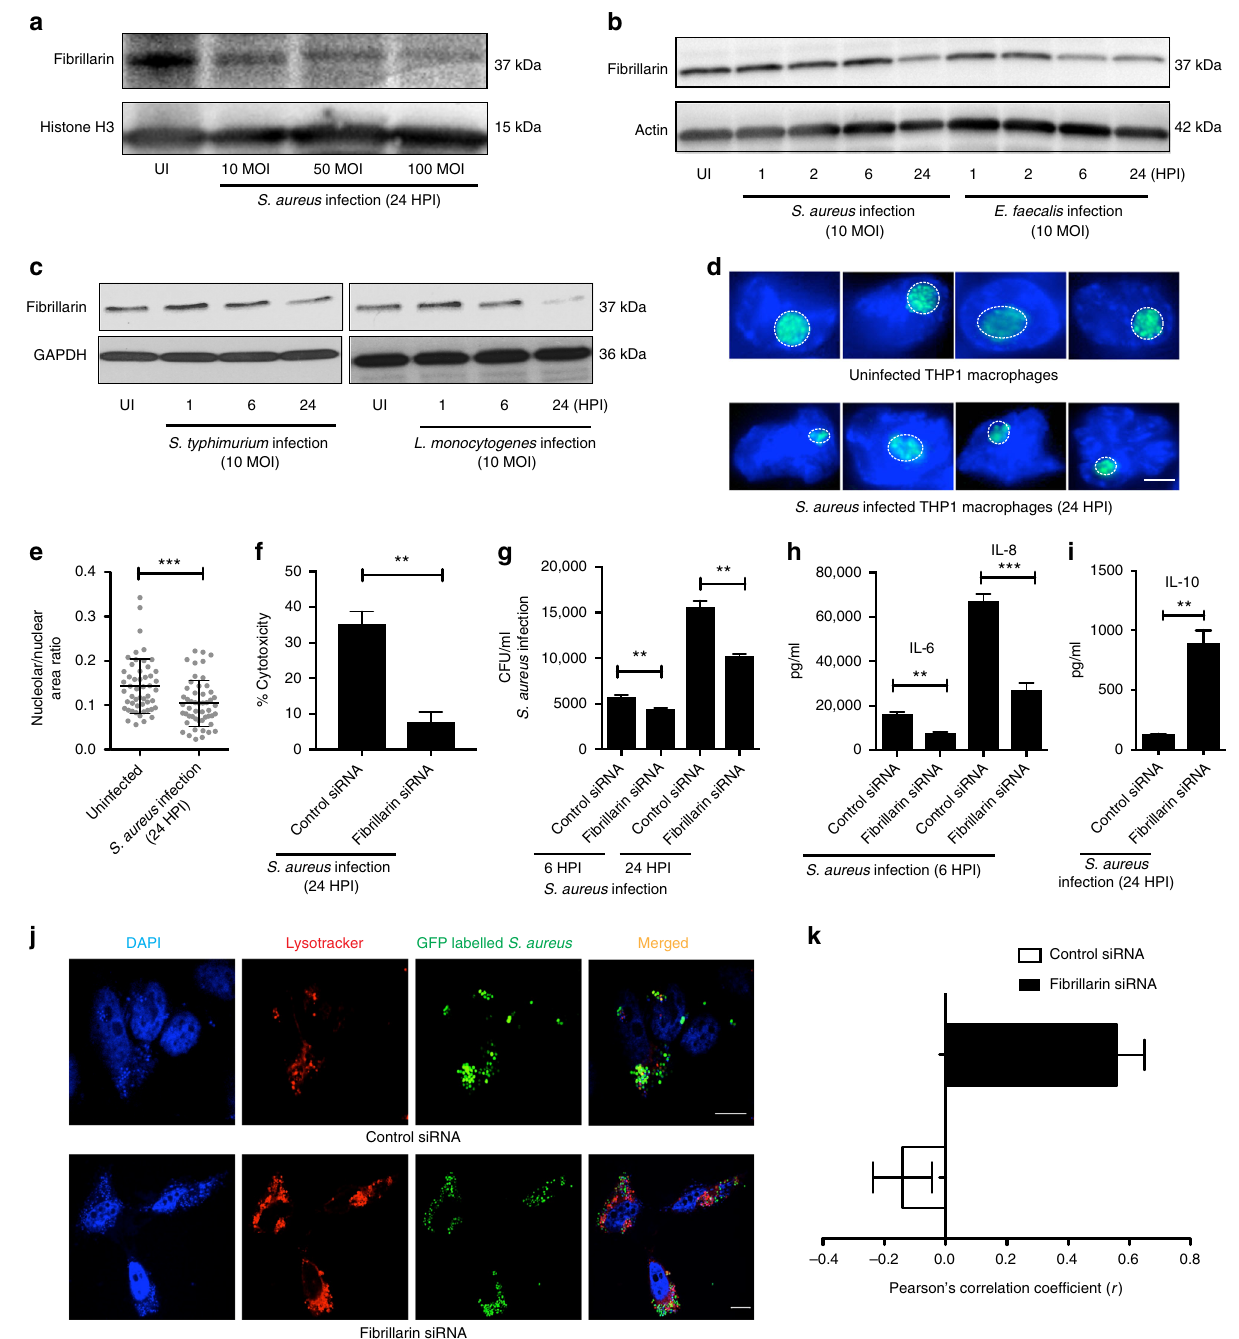
Fig. 5 Fibrillarin reduction protects mammalian cells against bacterial pathogens. a S. aureus infection leads to a reduction of fi brillarin levels in HeLa cells. b , c Mouse bone marrow-derived macrophages show a reduction in fi brillarin 24 h post infection with S. aureus , E. faecalis , S. typhimurium and L. monocytogenes . d , e Twenty-four hours of S. aureus infection leads to a reduction in nucleolar size of THP1 macrophages. Error bars represent mean ± s.d. f Fibrillarin siRNA reduces cytotoxicity relative to control siRNA after 24 h of S. aureus infection (MOI 10) in murine bone marrow-derived macrophages. Error bars represent mean ± s.e.m., unpaired t -test. g Fibrillarin siRNA leads to a better clearance of intracellular pathogens thereby lowering the number of CFU per mL after 6 and 24 h of S. aureus infection (MOI 10) in murine bone marrow-derived macrophages. Error bars represent mean ± s.e.m., unpaired t -test. h Six hours after S. aureus infection, ELISA results show a decrease in pro-in fl ammatory cytokines interleukin 6 and 8 after fi brillarin siRNA treatment in HeLa cells. Error bars represent mean ± s.e.m., unpaired t -test. i ELISA results show an increase in anti-in fl ammatory cytokine interleukin 10, 24 h post infection with S. aureus upon fi brillarin knockdown in mouse bone marrow-derived macrophages. Error bars represent mean ± s.e.m, unpaired t -test. j , k HeLa cells infected with GFP-labeled S. aureus and stained with lysotracker show increased co-localization of bacteria with lysosomes in cells treated with fi brillarin siRNA. ** P < 0.01, *** P < 0.001, unpaired t -test. Scale bars represent 4 ( d ) and 10 μ m ( j ). UI uninfected, HPI hours post infection,